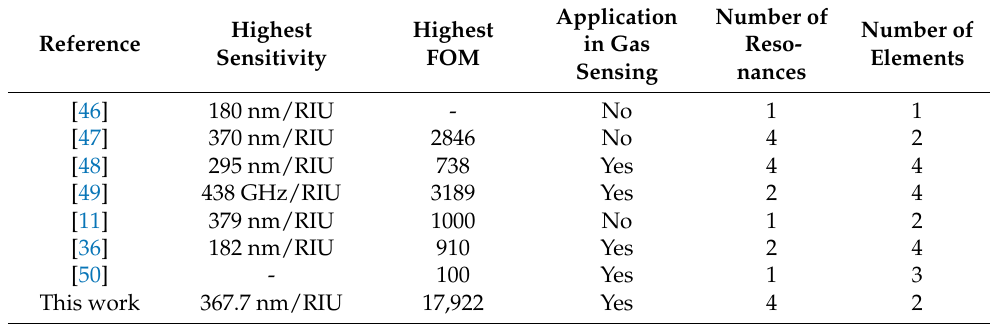
Table 2. Comparison of